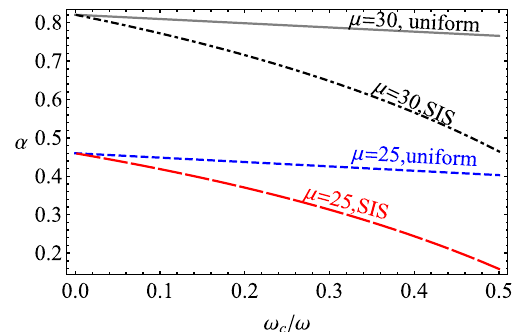
Fig. 7 Relations between degeneracy values of plasma frequency and the MOG parameter for the same total magnification value for uniform plasma model and SIS